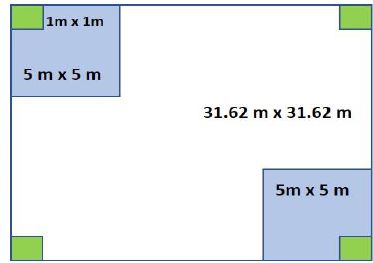
Figure 2. Field sampling plot design for aboveground biomass and carbon stock